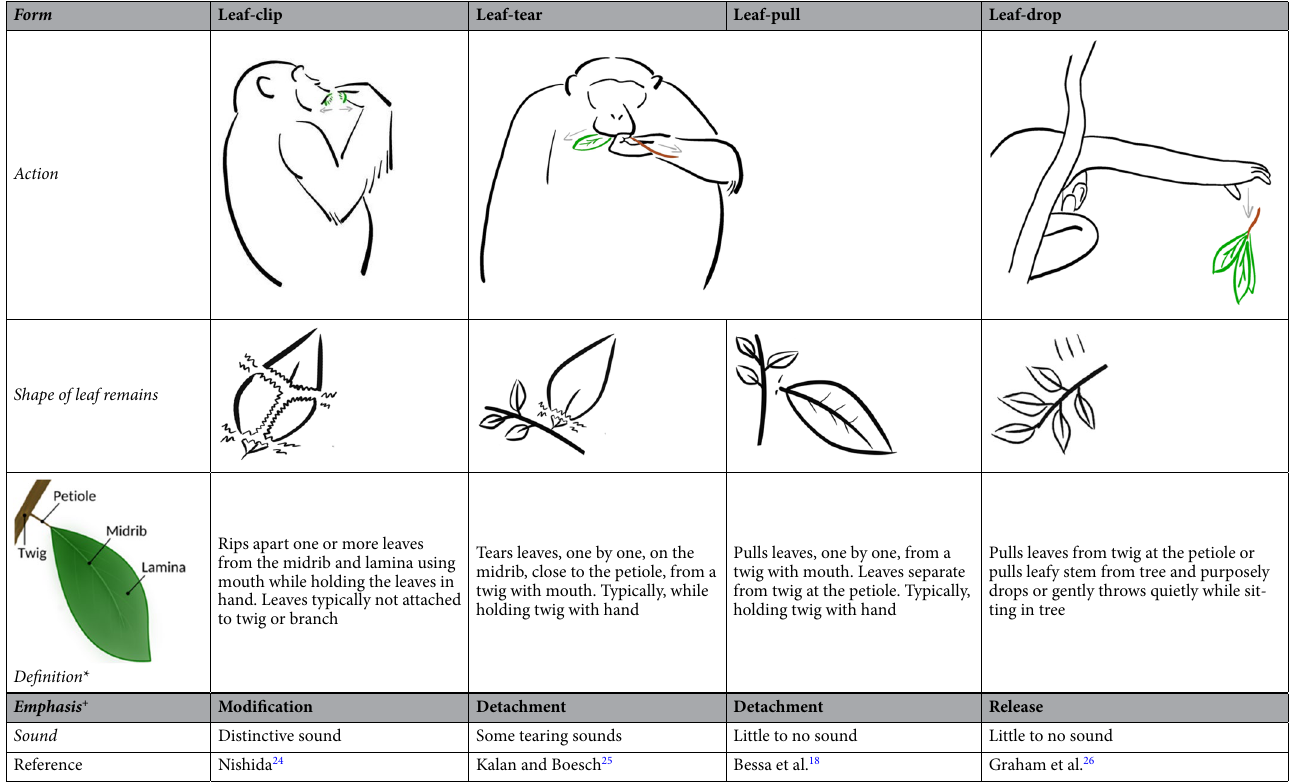
Table 2. Descriptions of four forms of leaf-modifying gestures used in this paper. Video examples of gesture forms can be found in ESM Videos 1–4. *Labelled diagram of leaf/ leafy stem parts used in descriptions of leaf- modifying gestures. + Emphasis: here we highlight which part of the gestural action includes the most salient leaf-modification (e.g., modification, through ripping, of the leaves during